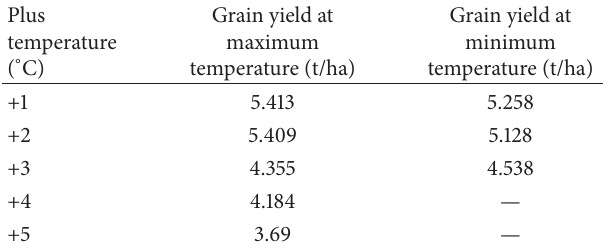
Table 5: Effects of plus maximum and minimum temperatures on simulated Basmati 370 yield grain under SRI in Mwea, Kenya.